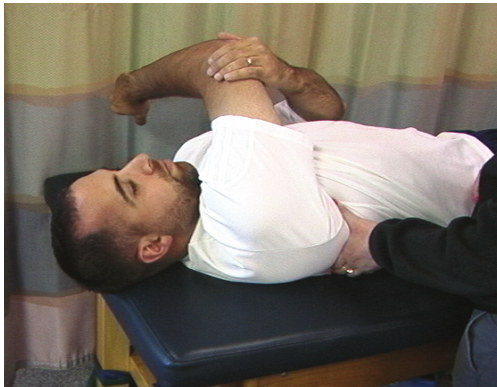
Figure 2: Cross-body stretch.